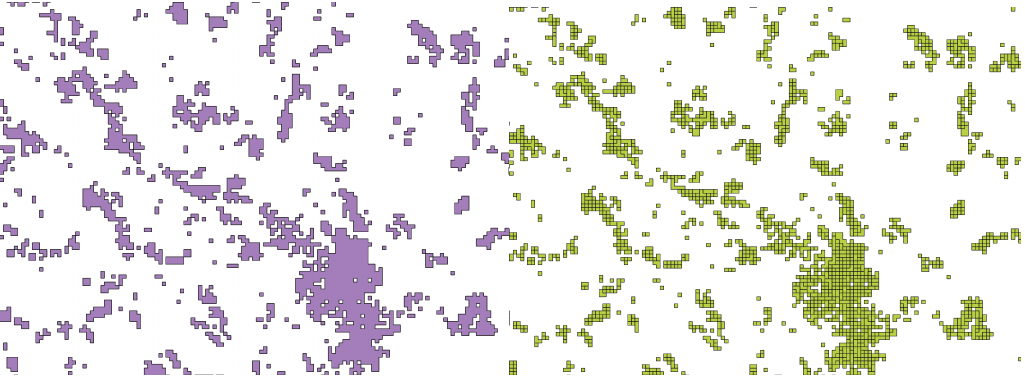
Figure A2. Uniform ( left ) and multi-part ( right ) population clusters created from HRSL .